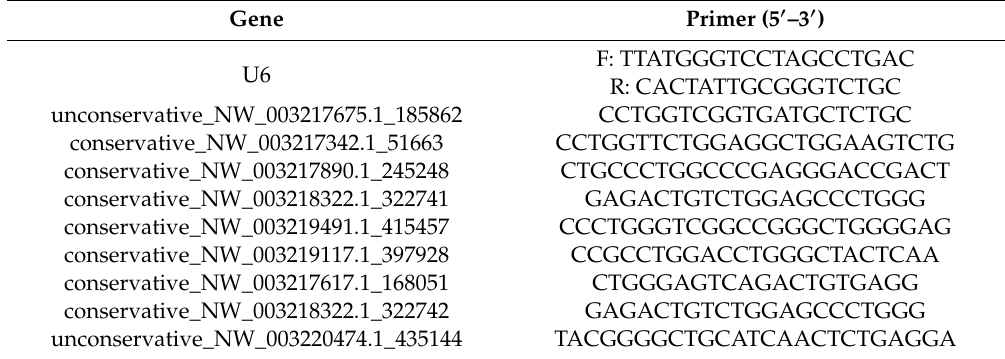
Table 1. Primers of di ff erentially expressed miRNAs used in quantitative reverse transcriptase PCR